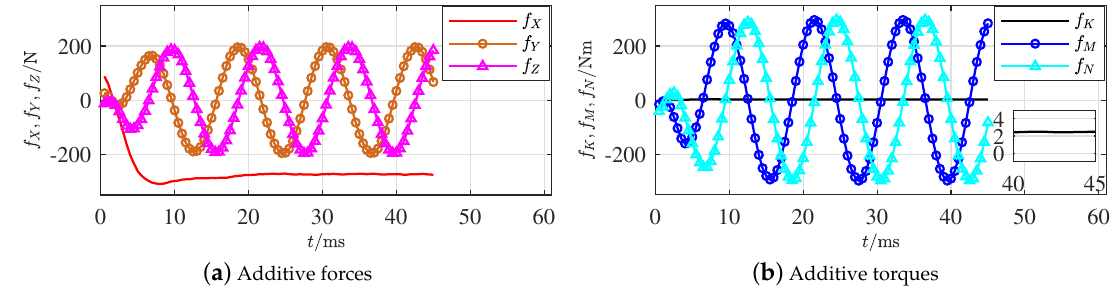
Figure 5. Additive forces and torques of propeller faults outside the hull.